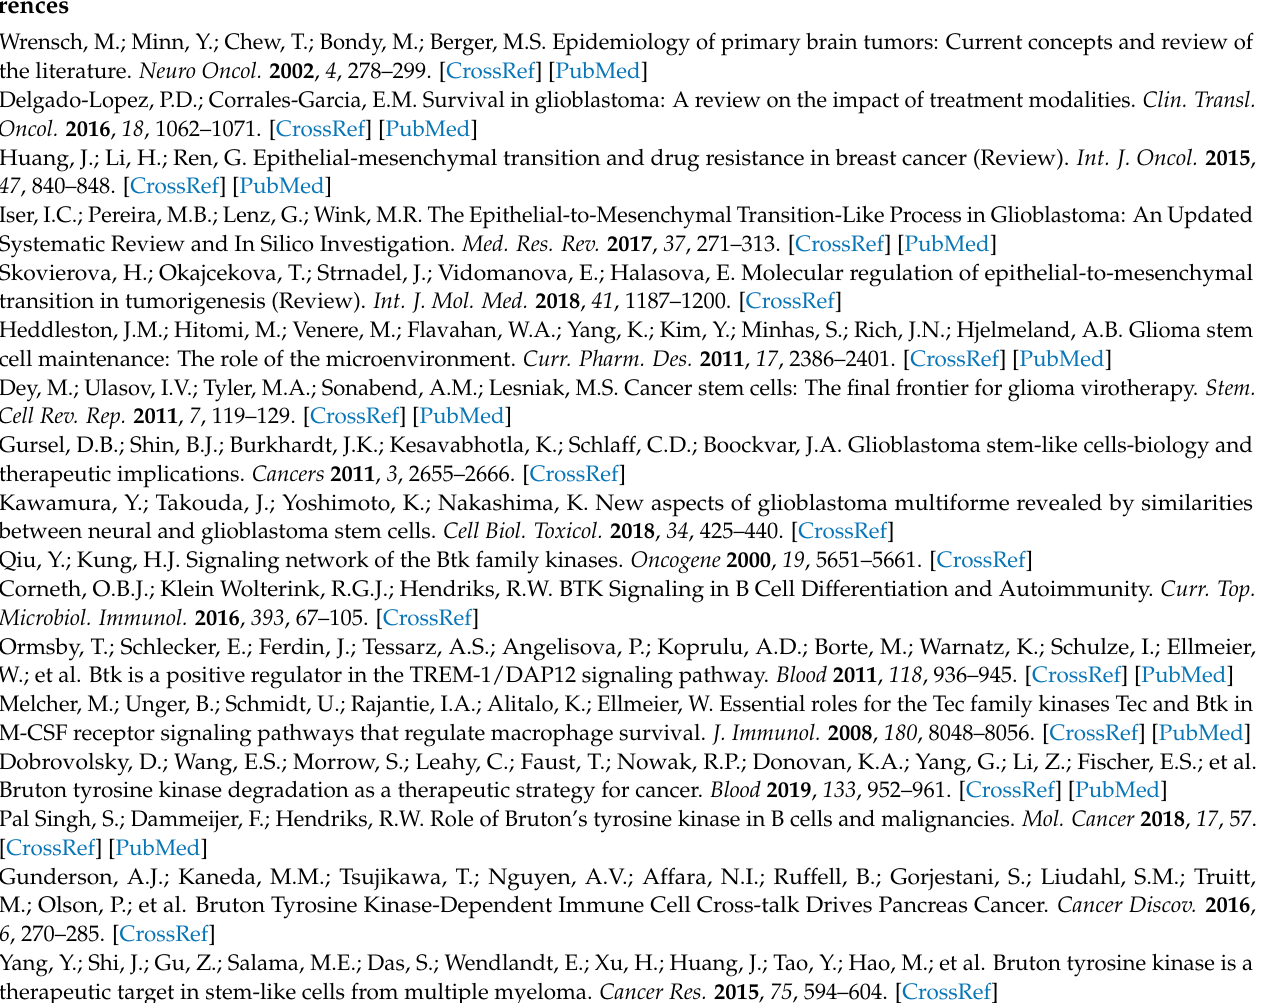
Figure S1. Combined Ibrutinib and Torin2 exhibits synergism, Supplementary Figure S2. Full-size blots of Figure 2C, Supplementary Figure S3. Full-size blots of Figure 4C, Supplementary Figure S4. Full-size blots of Figure